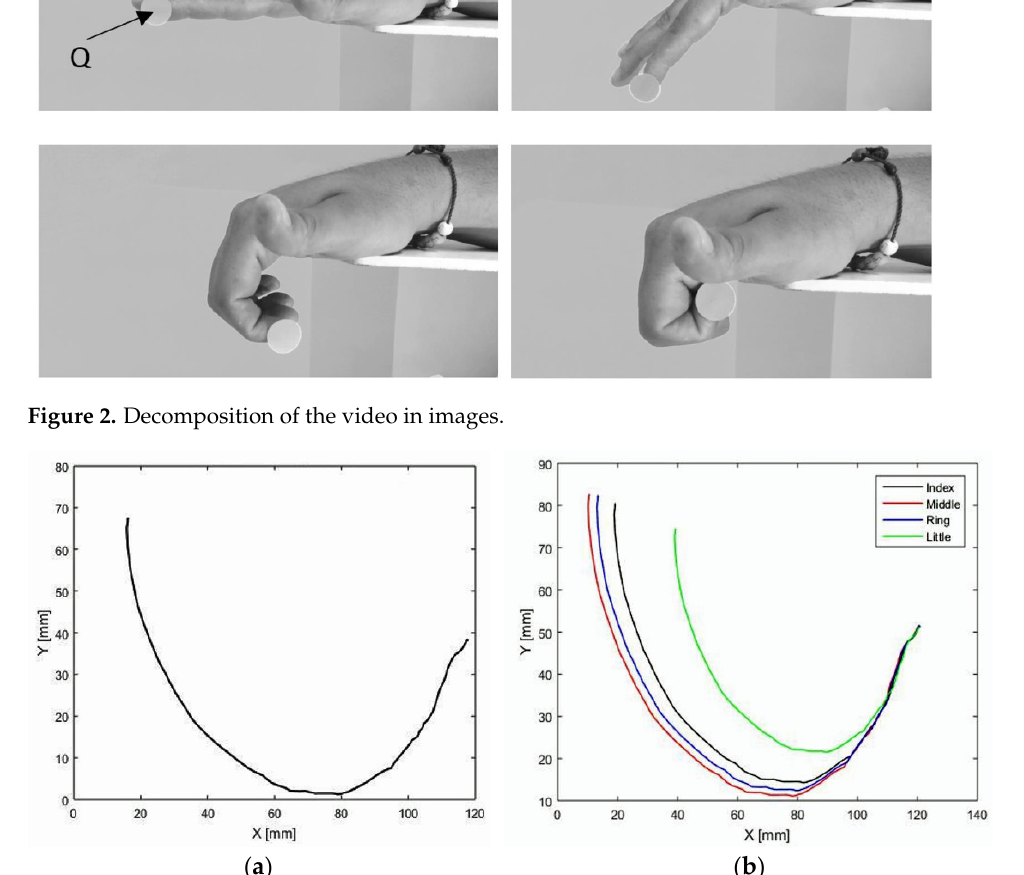
Figure 2. Decomposition of the video in images.